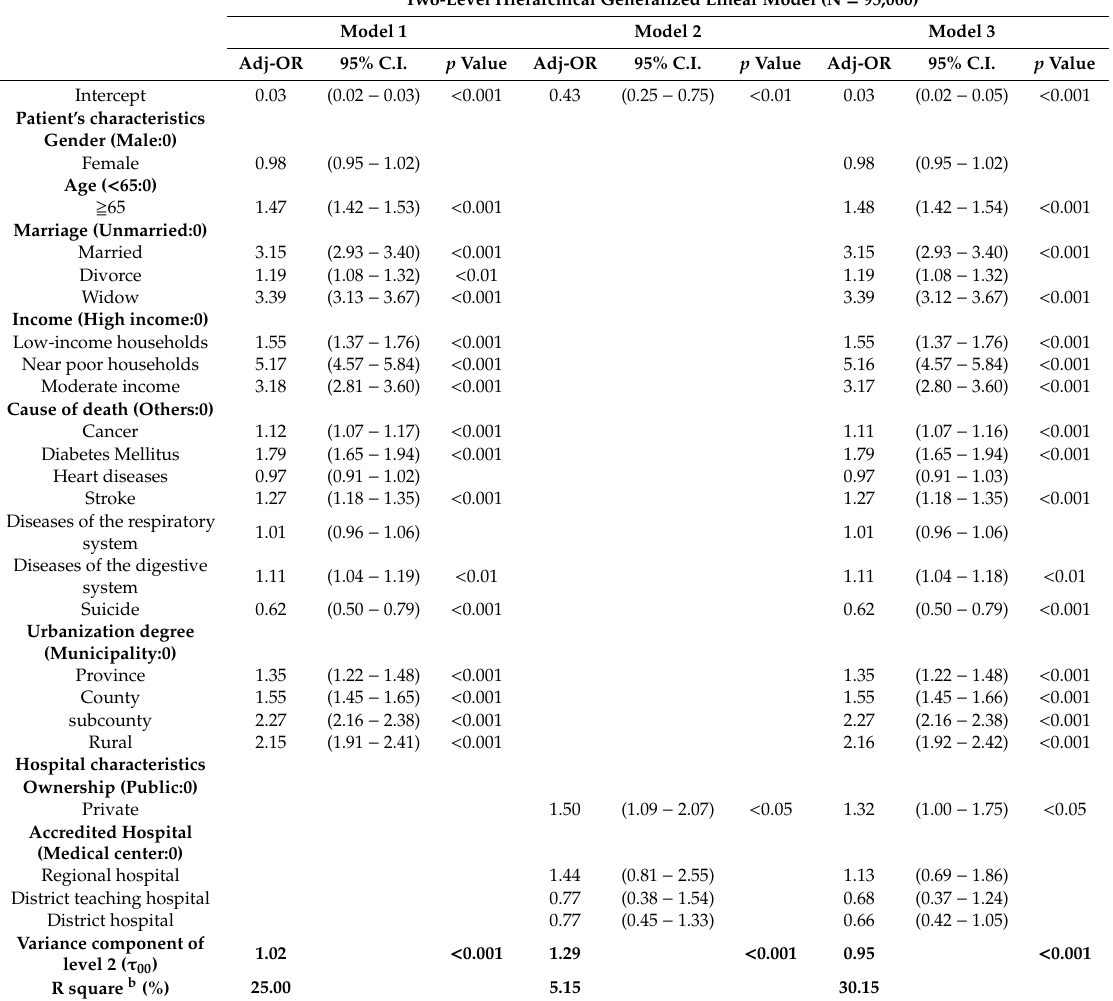
Table 2. Factors a ff ecting the discharge of inpatients facing impending death: two-level hierarchical generalized linear